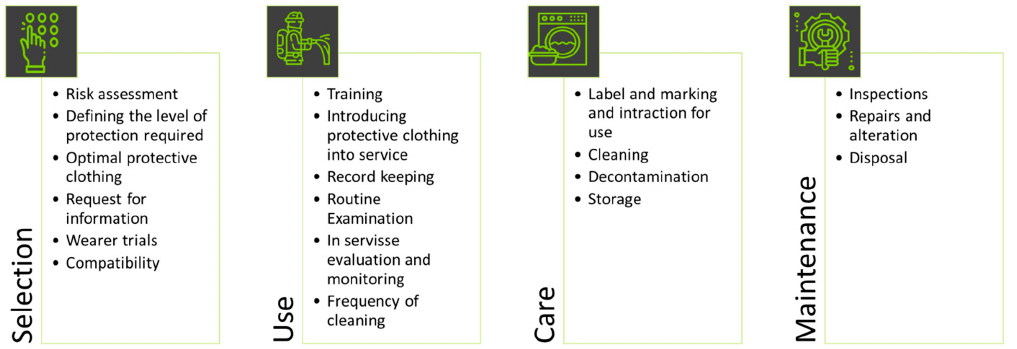
Figure 2. Main topics approached in the SUCAM guideline.